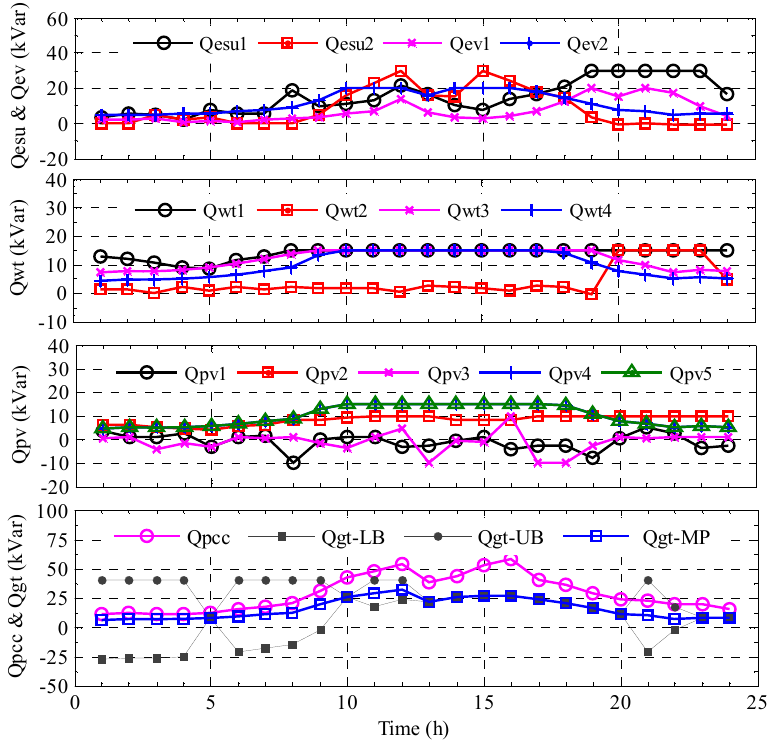
Figure 9. Reactive power of ESUs, EVs, WTs, PVs, PCC and GT in 24